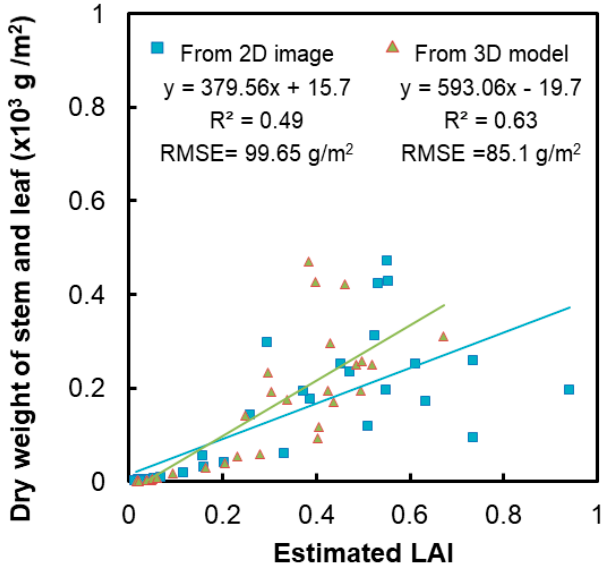
Figure 9. The comparison of sweet potato dry weight of stem and leaf versus estimated LAI.